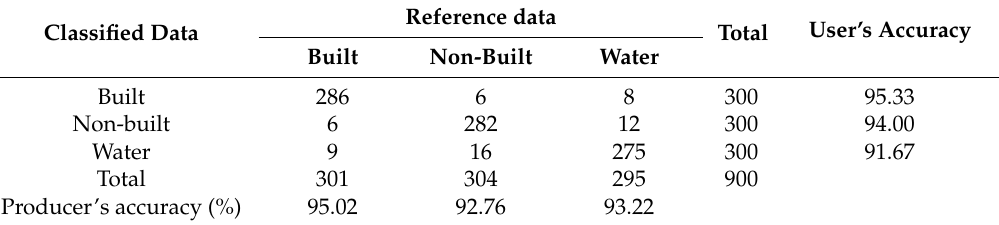
Table A3. Error matrix for the classified 2014 land use/cover